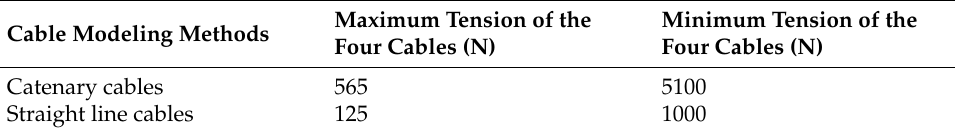
Table 3. Cable tensions of the two cable modeling methods along the spatial spiral trajectory. Cable Modeling